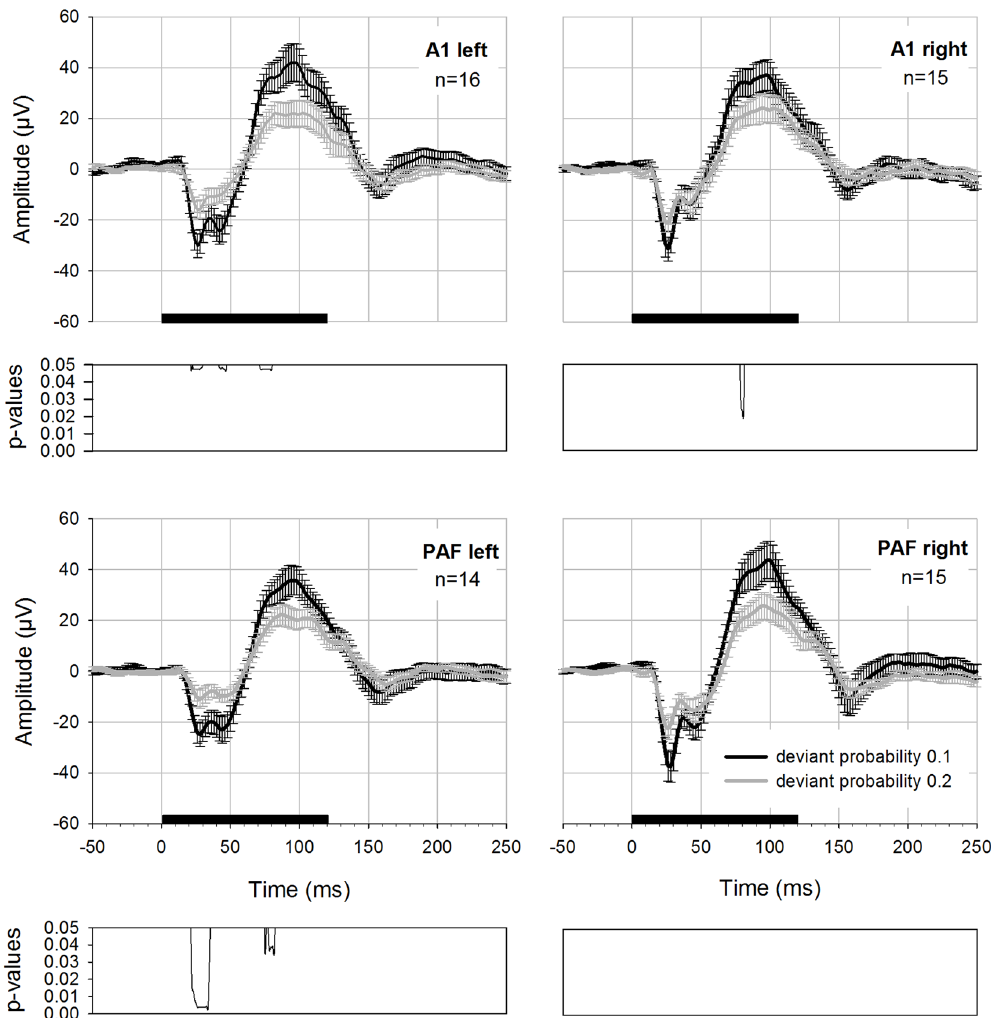
Figure 4. MMN-like activity displayed as difference waveforms for two deviant probabilities. Difference calculated as deviant minus standard potential displayed for four electrodes. Potentials were elicited using an oddball paradigm with deviant probability 0.1 (black curve) and 0.2 (grey curve). Black bar on the x-axis shows the stimulus duration. Below each graph FDR-corrected p-values are shown.